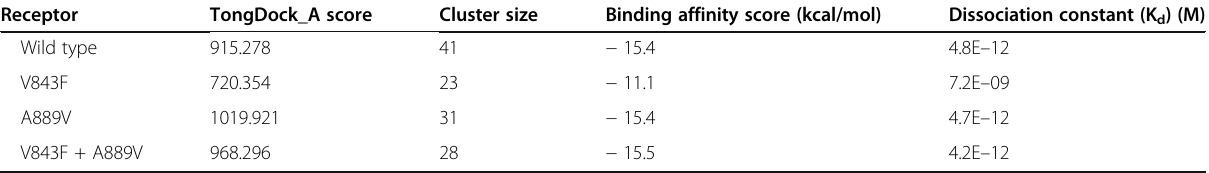
Table 4 Interaction between wild-type and mutant SARS-CoV-2 papain-like viral protease with ISG-15 Receptor TongDock_A